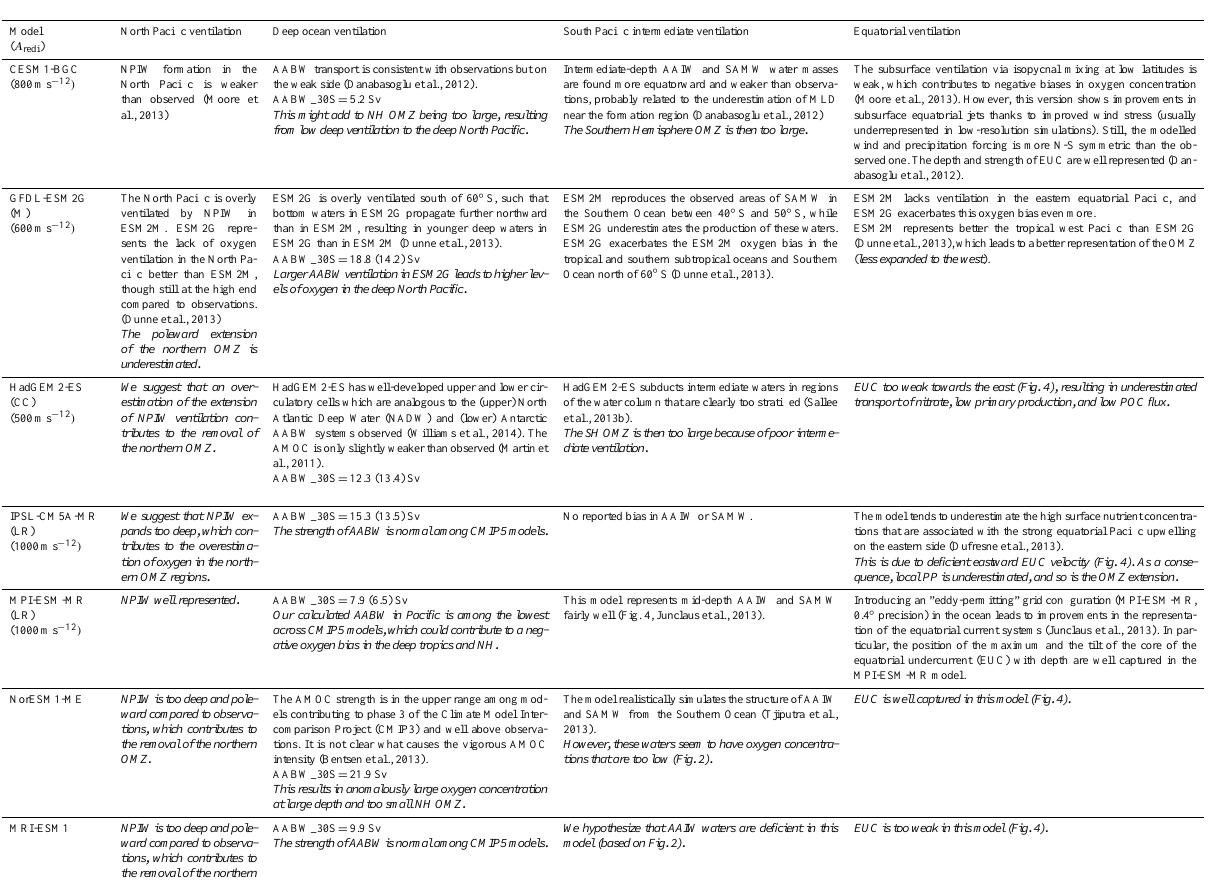
Table A2. Description of ventilation sources across CMIP5 models, including North Pacific ventilation via NPIW, deep ventilation via AMOC and AABW, intermediate-depth South Pacific ventilation via AAIW and SAMW, and equatorial ventilation. The diapycnal mixing coefficient A redi (collected from references in Table 1) is shown in parentheses in the first column. The AABW strength is calculated as the maximum value of the lower cell in the Indo-Pacific meridional stream function at 30 ◦ S. Fig. S9 shows the stream function across CMIP5 models. Italic entries show contributions from the present research; regular font shows literature